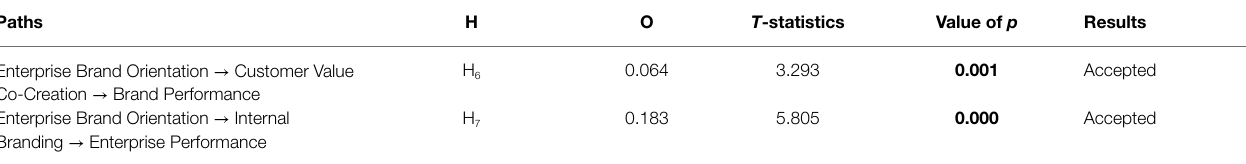
TABLE 5 | Indirect effects of the variable. Paths